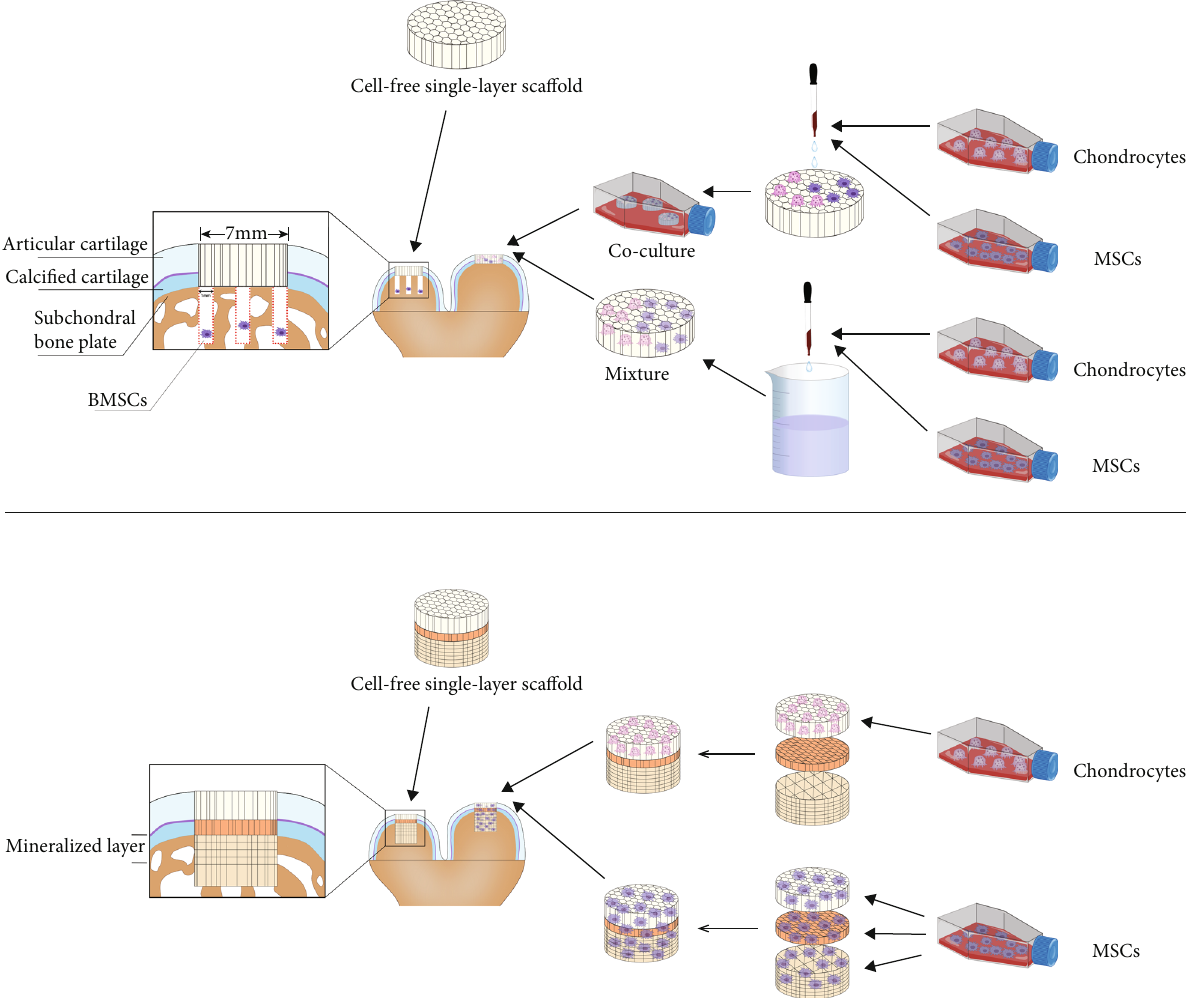
Figure 1: Schematic diagram of full-thickness cartilage or osteochondral sca ff old loading of cells in vitro and implantation in the defect